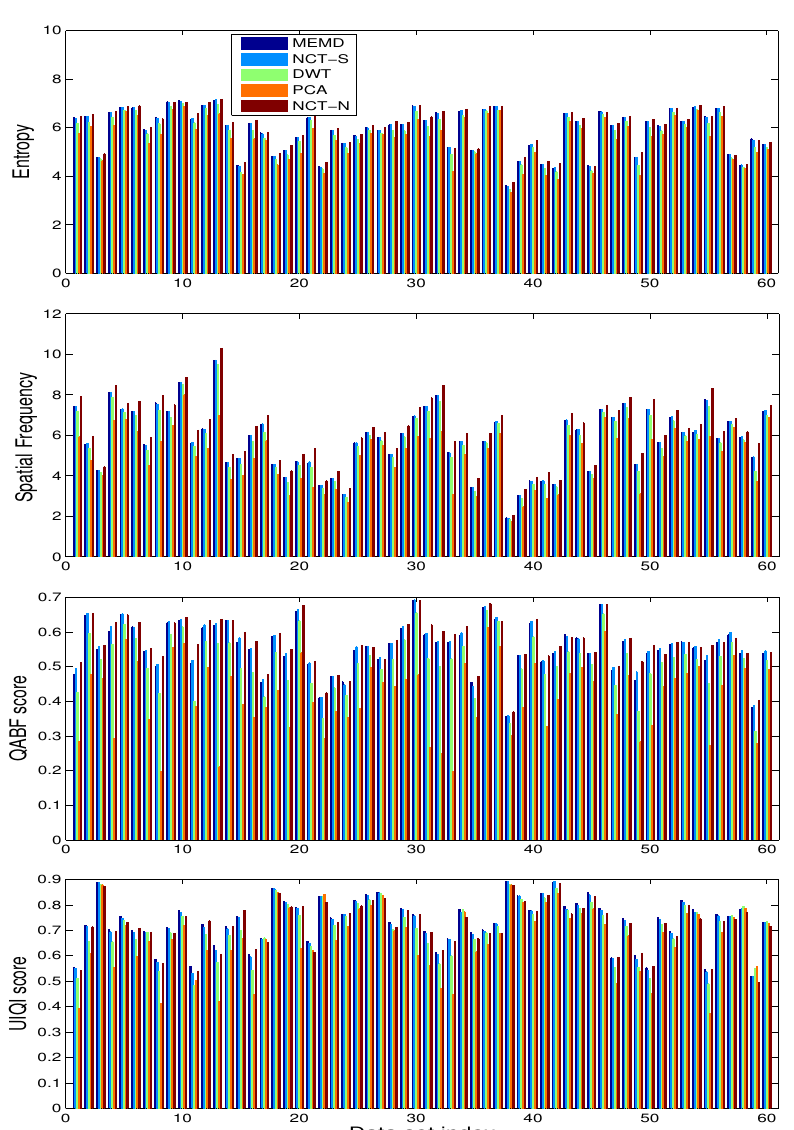
Figure 11. Quantitative analysis on multi-exposure images: bar graphs of the values of quantitative measures, including the E , SF , Q AB/F and UIQI , shown respectively from P the top to the bottom, are obtained for MEMD-, NCT-S-, DWT-, PCA- and NCT-N-based fusion